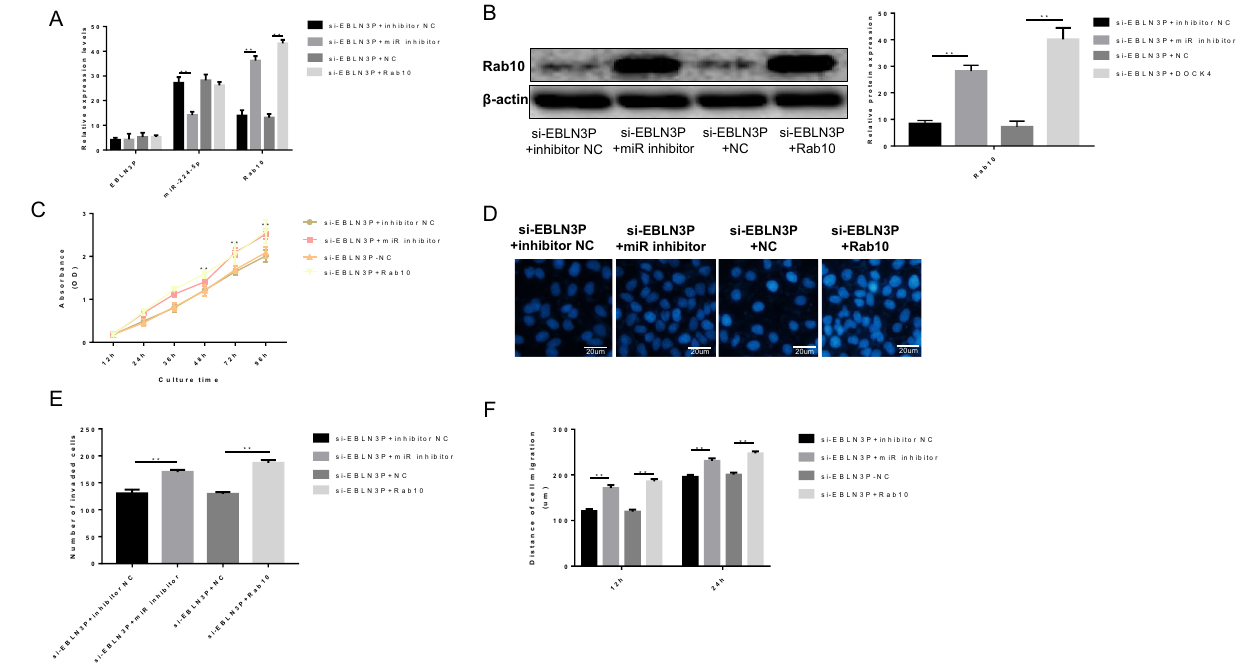
Figure 5. EBLN3P regulated the aggressive behavior of osteosarcoma cells via the miR-224-5p/Rab10 loop. ( A , B ) Overexpression of Rab10 was achieved via transfecting the cells with pcDNA3.1 ‐ Rab10 or miR-224-5p inhibitor. The knockdown of EBLN3P markedly reduced cell proliferation, migration and invasion. However, co-transfection with si-EBLN3P and miR-224-5p inhibitor or Rab10 significantly increased cell proliferation, migration and invasion, in contrast to cells transfected with si-EBLN3P alone (Fig. 4C–F). EBLN3P endogenous bornavirus-like nucleoprotein, Rab10 Ras-related protein